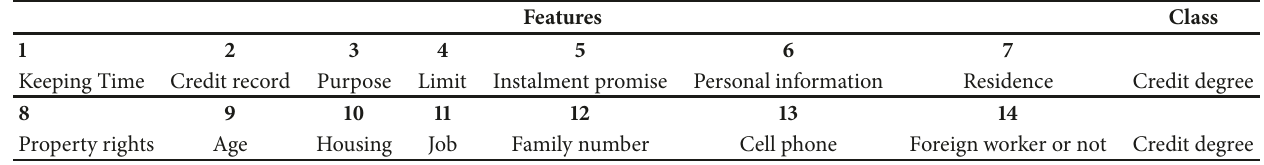
Table 6: The 14 features and classes of dataset “Credit”.